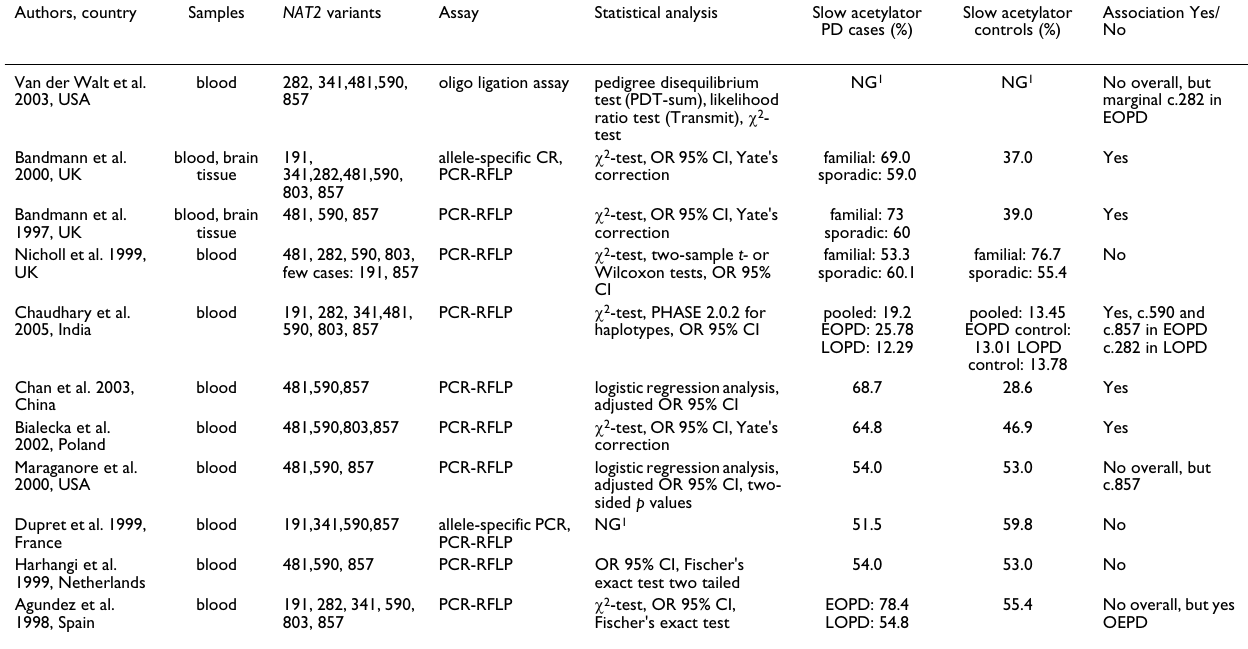
Table 4: Characteristics of studies on NAT2 polymorphisms and Parkinson's disease: genetic and disease-association analyses Authors,